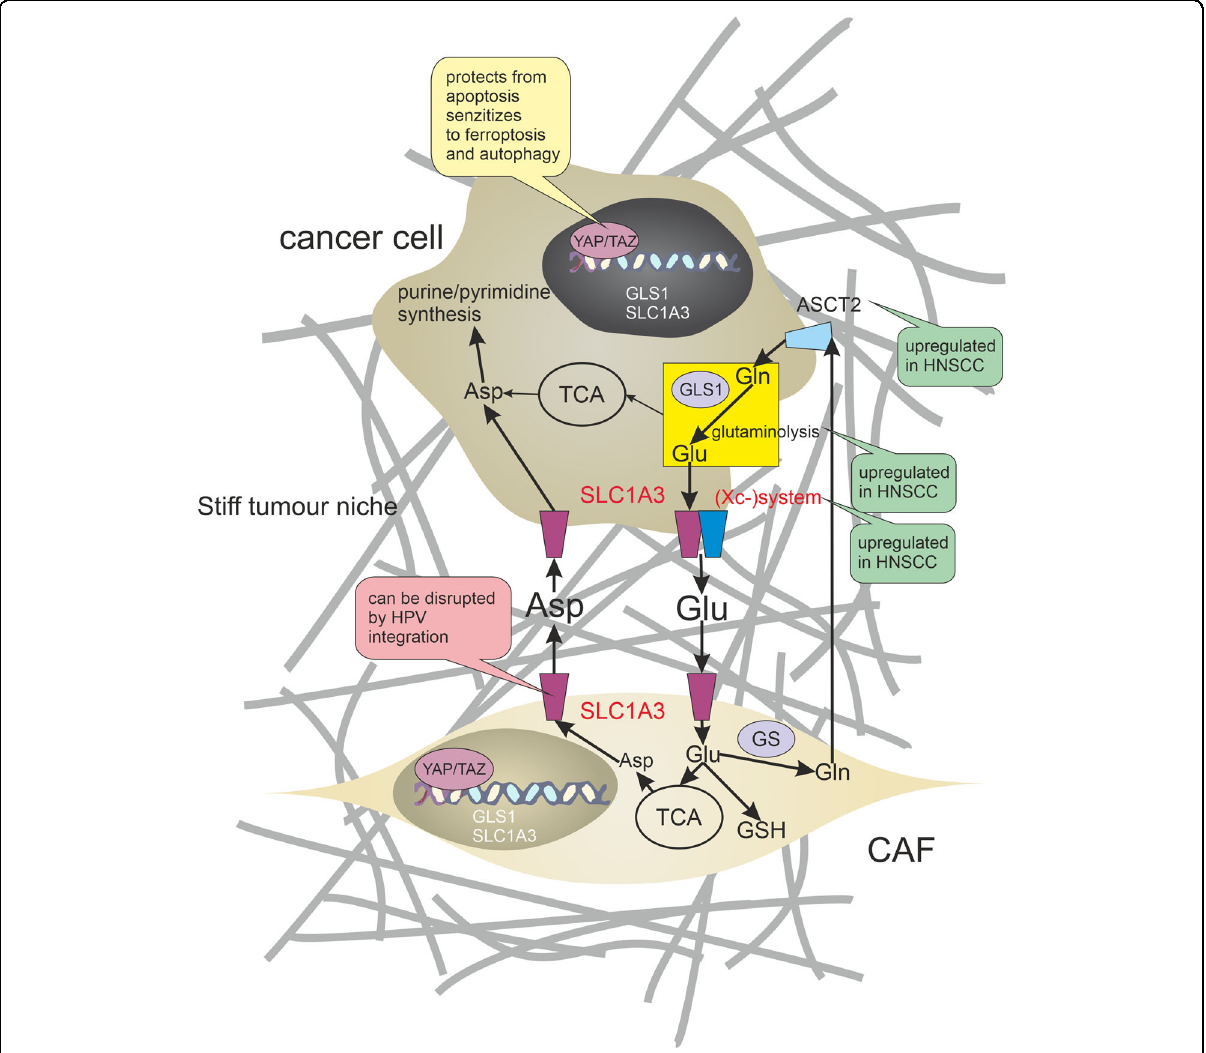
including increased glutaminolysis. Glutaminolysis produces large pools of intracellular glutamate. Upregulation of the cystine/glutamate antiporter ((Xc – ) system) and excitatory amino acid transporter (SLC1A3) promotes aberrant glutamate (Glu) release from cancer cells. Increased stiffness of extracellular matrix during tumour progression induces cancer-associated fi broblasts (CAFs) to import glutamate (through SLC1A3) and release aspartate (Asp) and glutamine (Gln) supporting cancer cell purine/pyrimidine synthesis. Glutamine synthetase (GS) is often overexpressed in these CAFs. CAFs can also promote chemoresistance through the production of glutathione (GSH). Establishing of this metabolic symbiosis is coordinated by a YAP/TAZ-dependent mechanotransduction pathway. Green bubbles indicate activation and pink inhibition of the